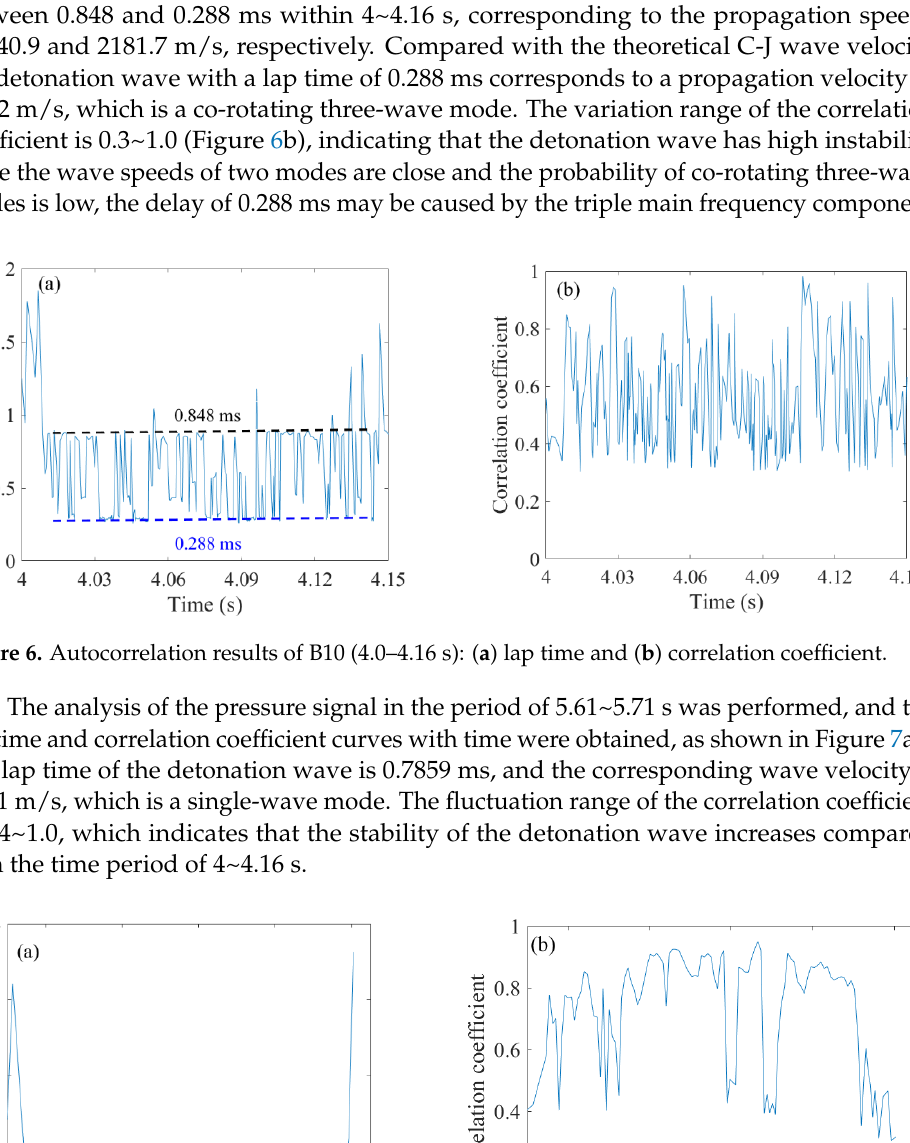
Figure 5. Autocorrelation results of B4: ( a ) lap time and ( b ) correlation coefficient.